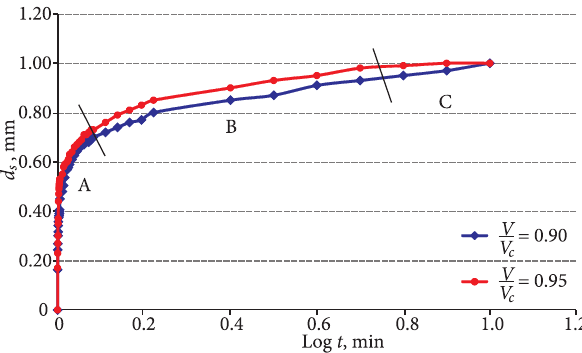
Fig. 3. Time evolution of scour